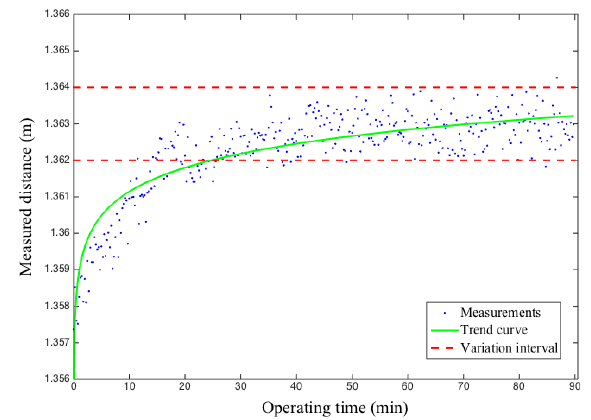
Figure 5. Value of distance measurements as a function of time